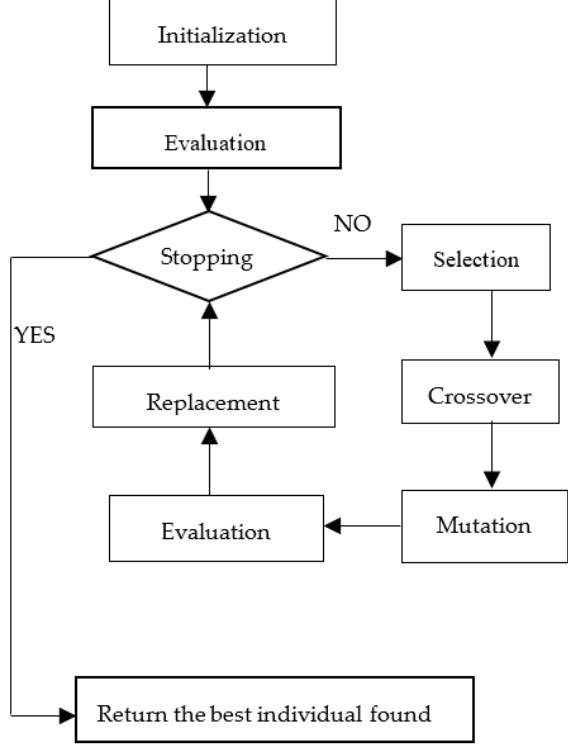
Figure 6. GA Figure 6. GA Flowchart.